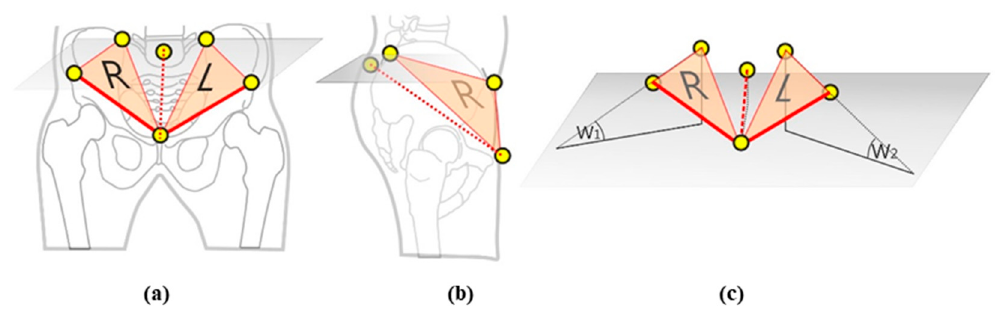
Figure 2. Simplified geometrical model: representation of the left and right hemi-pelvises by triangles between ASIS, PSIS, and symphysis. ( a ) Frontal view; ( b ) view from the right side; ( c ) angles W1 and W2 between the horizontal (transversal) plane and the triangles are the basis for the calculation of the pelvic torsion. Dotted lines: pelvic anteversion.